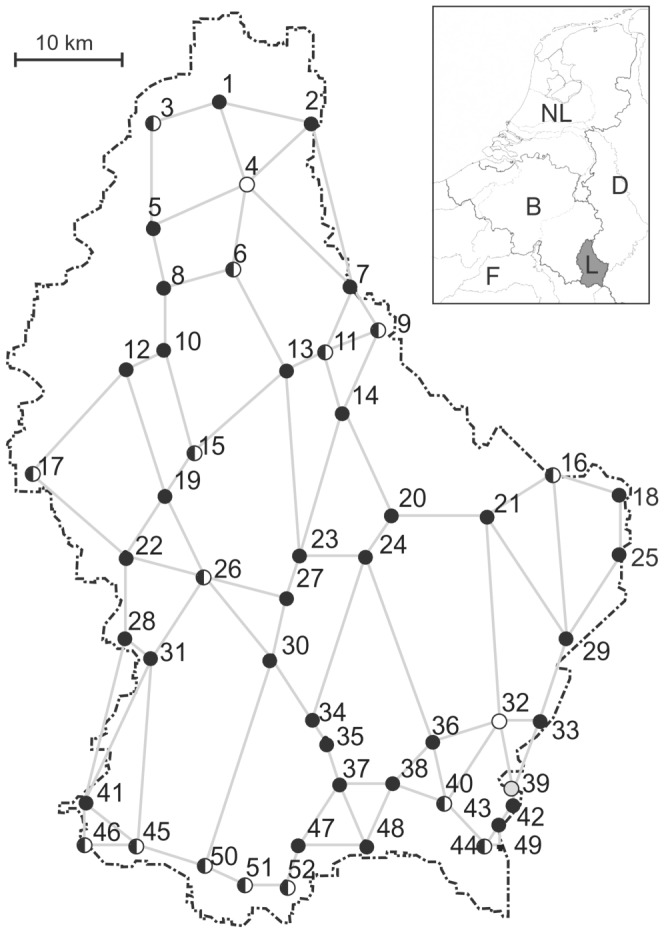
Sampling localities (n = 52) of synanthropic harvestmen in Luxembourg, connected by the Gabriel graph which was used as the definition of the neighbourhood.Numbers indicate settlements and refer to Table S1. Fillings indicate presence/absence of Opilio canestrinii and O. parietinus (black circles: only O. canestrinii, white circles: only O. parietinus, half-filled circles: both species, grey circles: none of the two species).